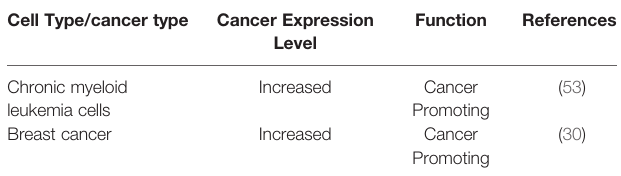
TABLE 2 | Expression of HIRA in